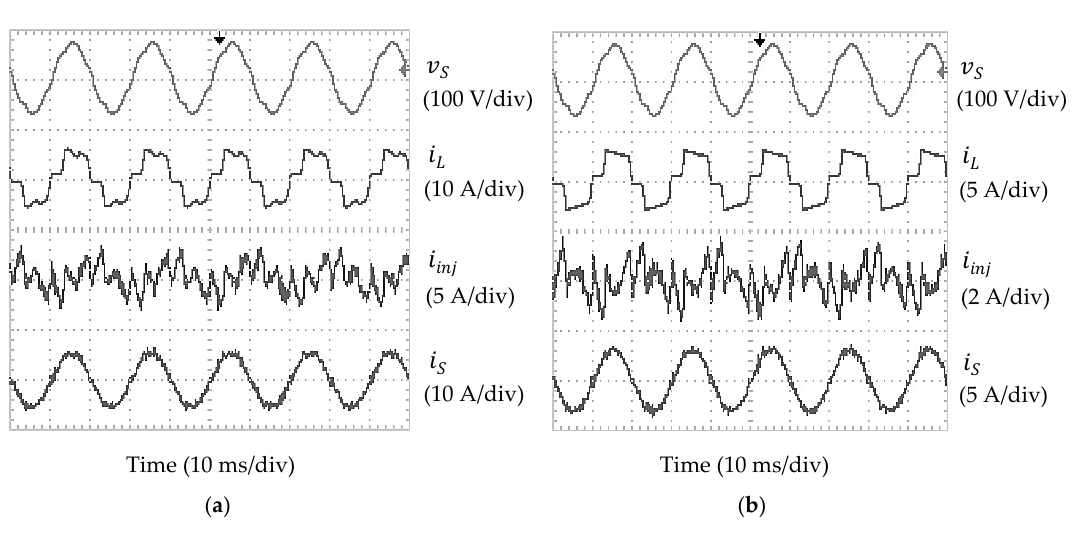
Figure 11. Steady-state experimental waveforms (phase A) of SAPF utilizing the refined STF-pq theory algorithm which include source voltage v S , load current i L , injection current i inj and source current i S for ( a ) resistive and ( b ) inductive loads.